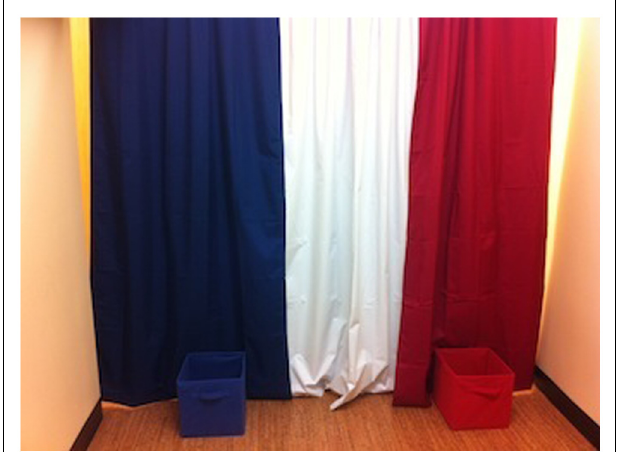
FIGURE 1 | Photograph of the room set-up for the experimental